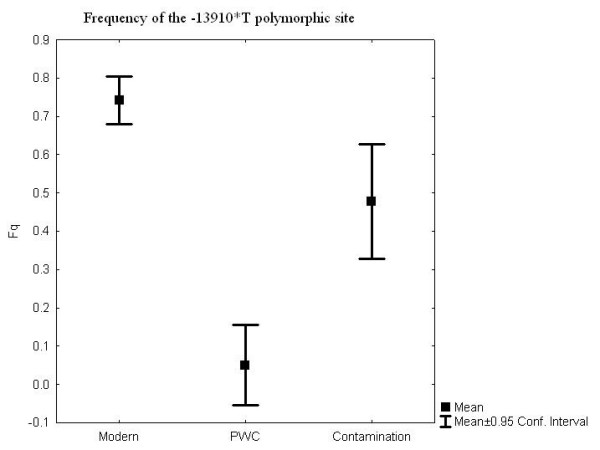
Frequency of the -13910*T polymorphic site in the lactase gene in three datasets: an extant Swedish population, a Swedish Neolithic hunter-gatherer population (PWC) and the negative controls.